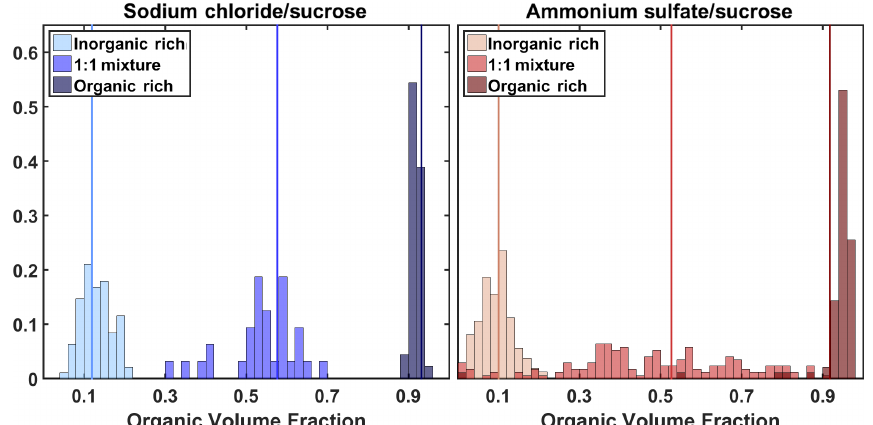
Figure 6. Organic volume fraction (OVF) histograms of both sodium chloride / sucrose (blue) and ammonium sulfate / sucrose (red) systems. The three mass ratios, 10 : 1 (inorganic rich), 1 : 1, and 1 : 10 (organic rich), are shown in different shades of color. The vertical line represents the bulk OVF value.